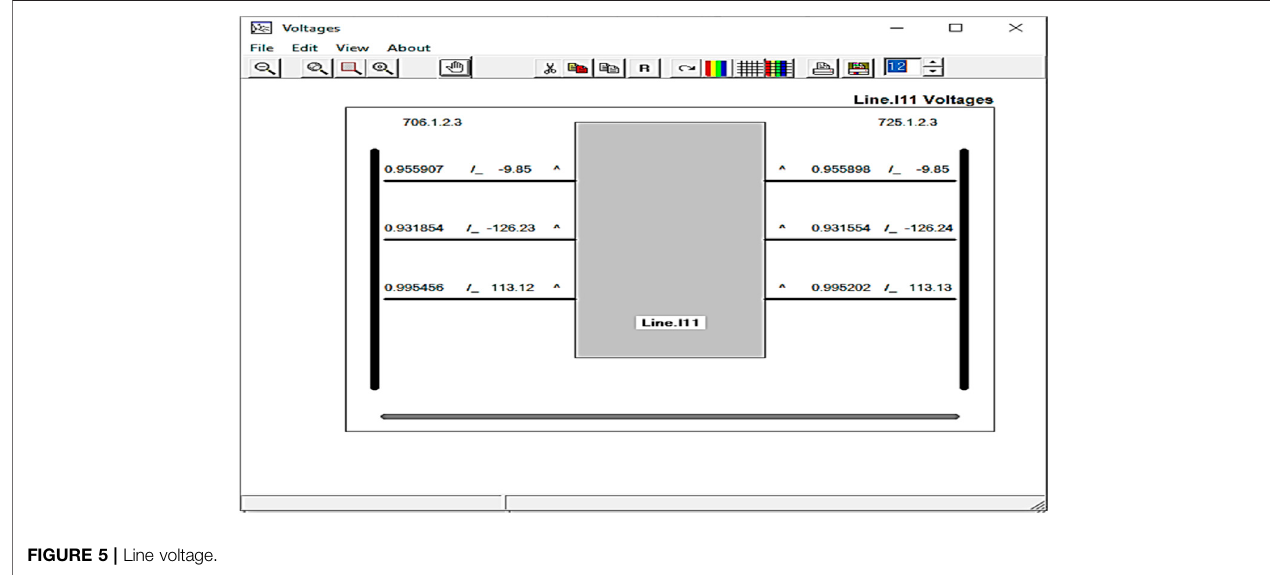
FIGURE 5 | Line voltage.